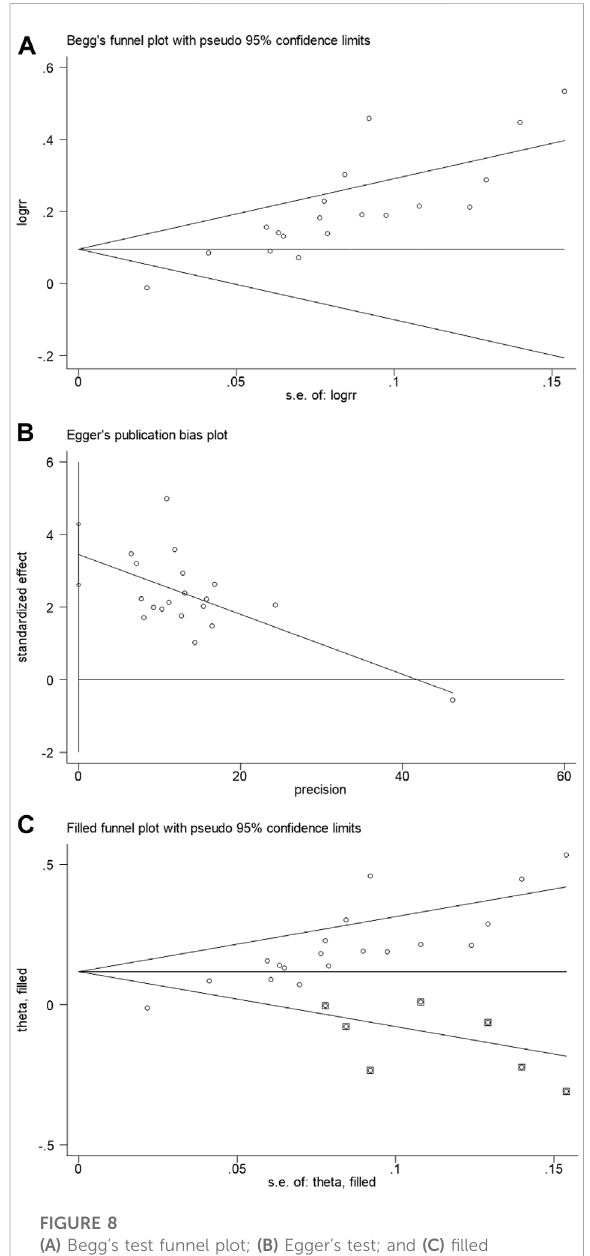
FIGURE 8 (A) Begg ’ s test funnel plot; (B) Egger ’ s test; and (C) fi lled funnel